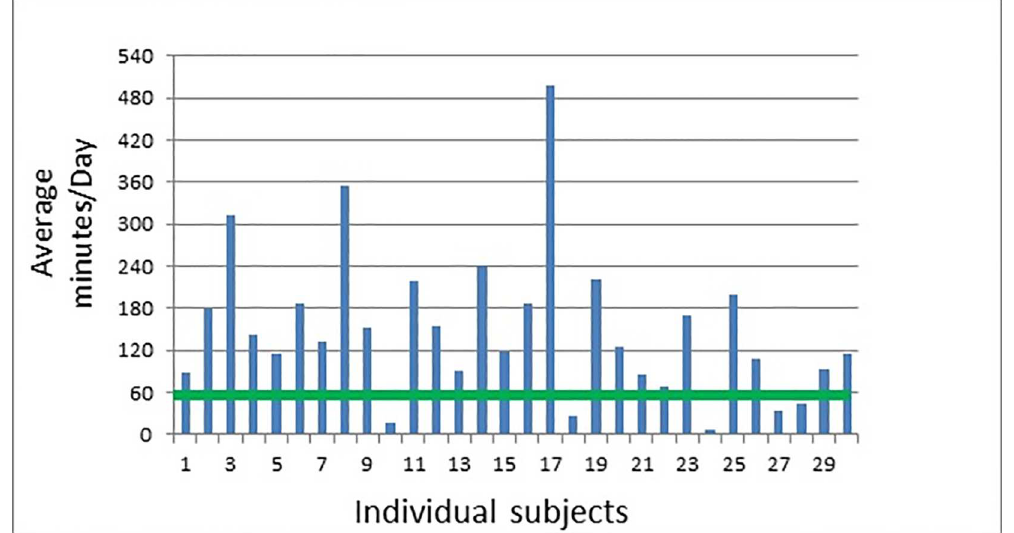
Fig 2. Individual Adherence Data. The bluevertical bars indicatethe averagenumberof minutes per day spent interacting with the mobiletablet for each subject. The green horizontalbar is set at the target 60 minutes per day recommended by the SLP.